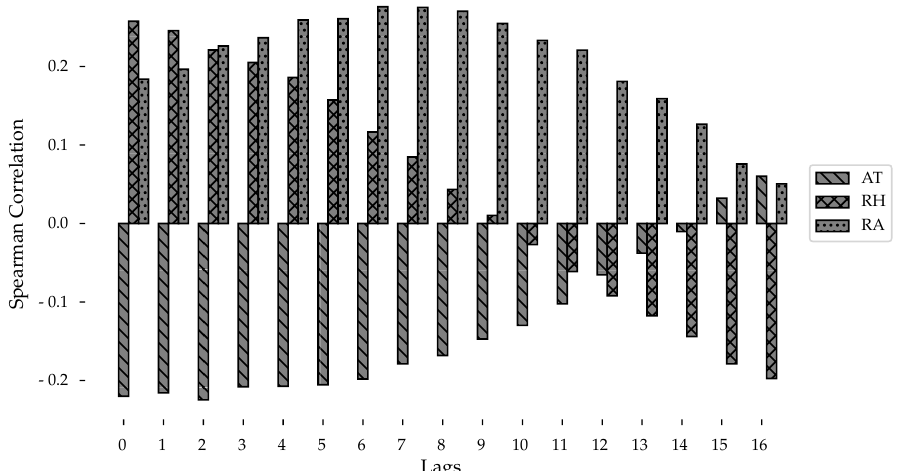
Figure 10. Variation in Spearman’s correlation coefficient as climatic variables are